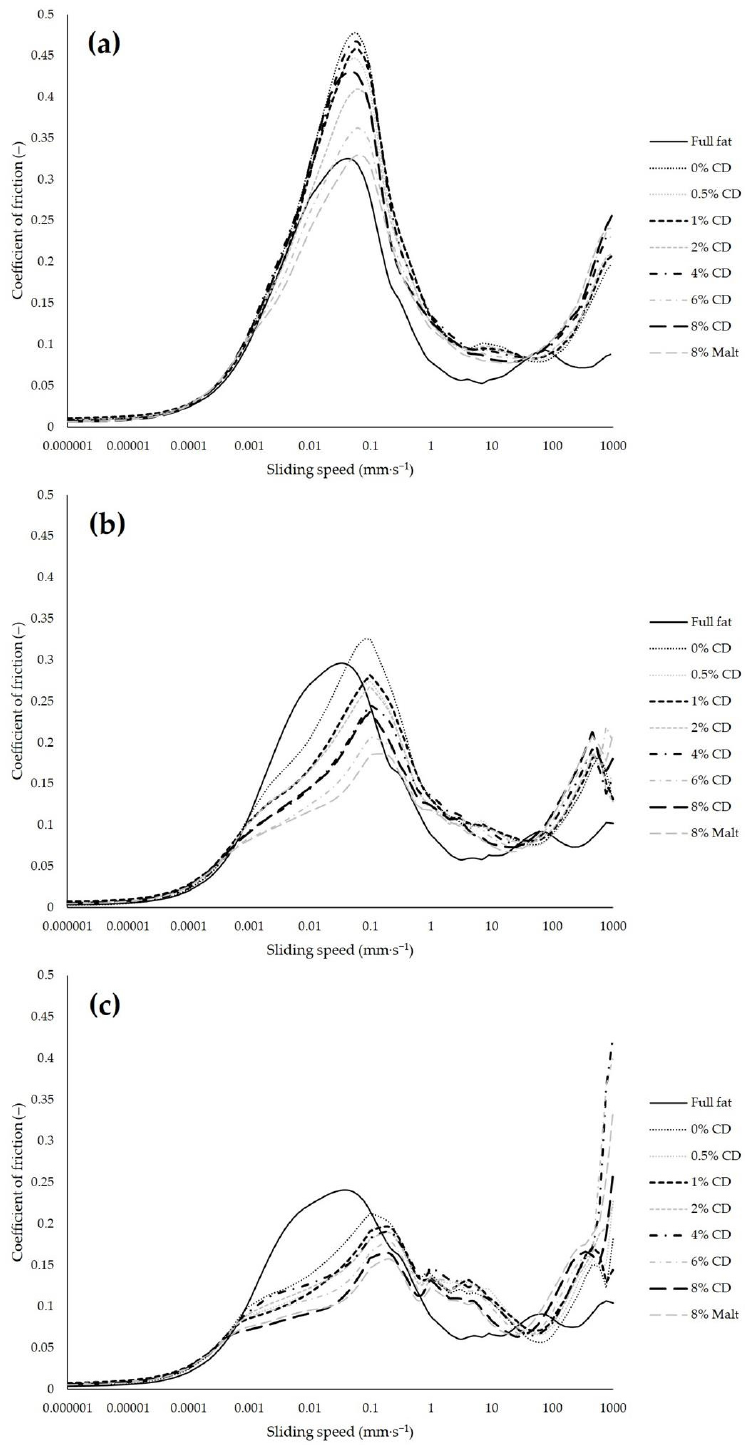
Figure 2. The Stribeck curve 1 ( a ), curve 2 ( b ), and curve 3 ( c ): the coefficient of friction versus the sliding speed of all mayonnaise formulations. The curves are mean values of all four measurements per each batch.